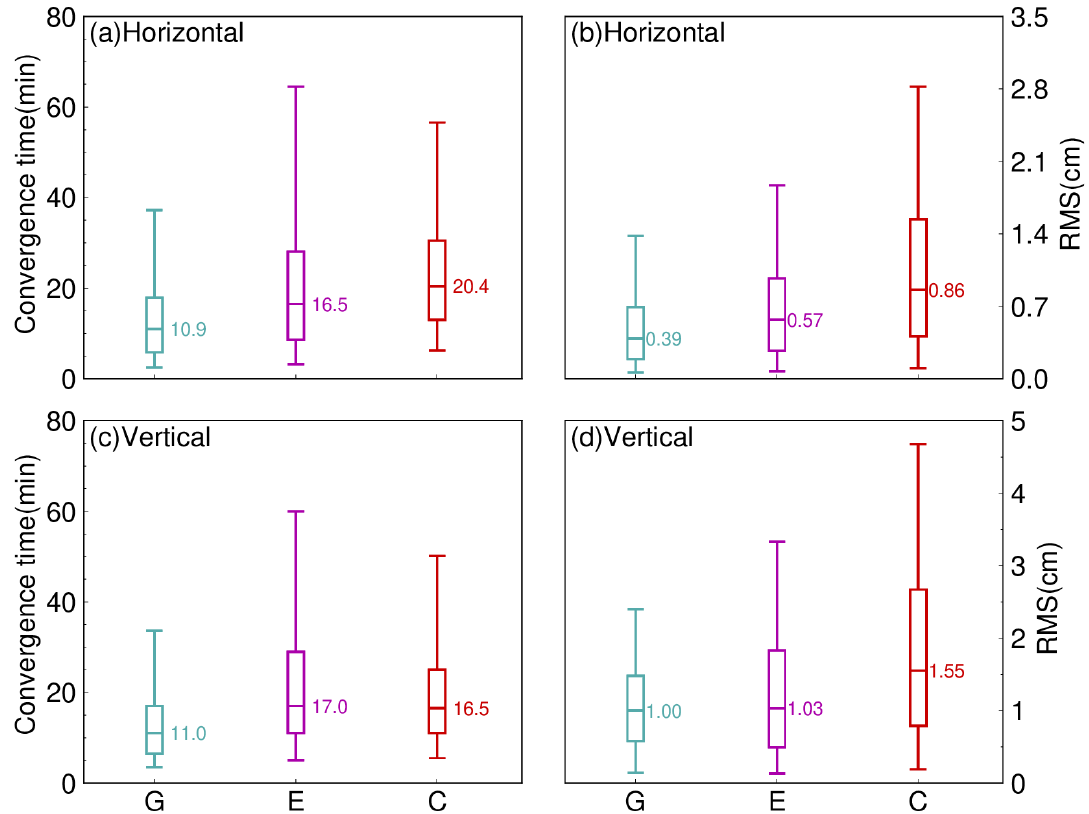
Figure 5. Distribution of the convergence time and RMS of static PPP solutions in three single systems (G is short for GPS, E is short for Galileo, and C is short for BDS-3) in September 2022. ( a ) Horizontal component of convergence time, ( b ) Horizontal component of RMS, ( c ) Vertical component of convergence time, ( d ) Vertical component of RMS.